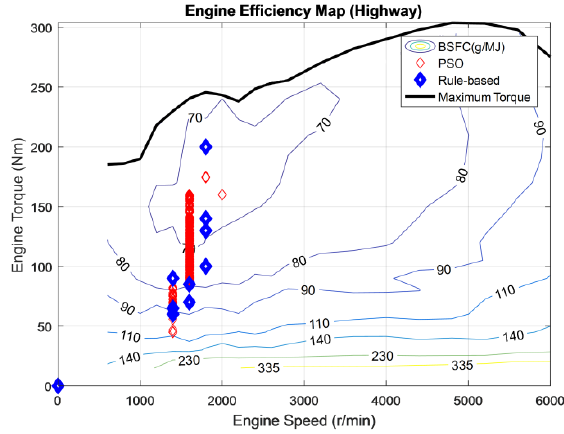
Figure 18. Comparison of urban engine operating points.